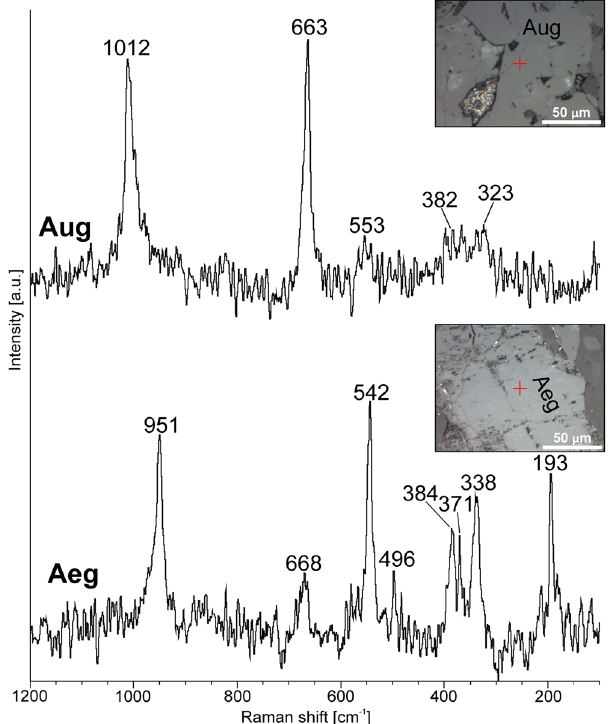
Figure 5. Raman spectra for augite (Aug) and aegirine (Aeg) in the spectral range of 1200–100 cm −1 along with corresponding photomicrographs (reflected light mode) and analytical point marked by red